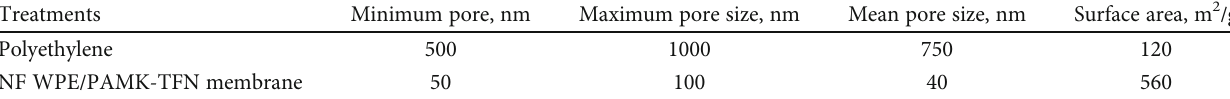
Table 2: Porosimetry data for polyethylene and NF WPE/PAMK-TFN membranes.